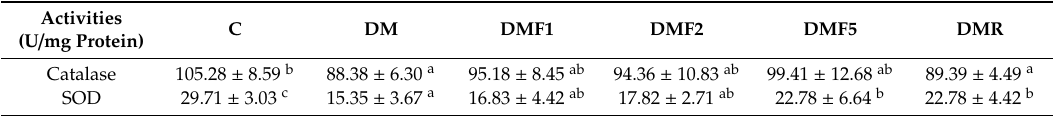
Table 3. Effects of fucoxanthin on enzymatic anti-oxidative activities of rat testes after treatment for four weeks.